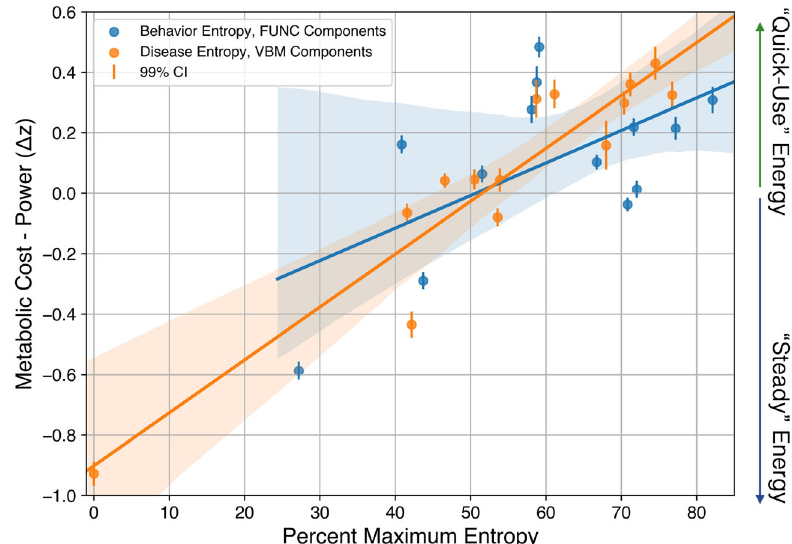
Fig. 5 Metabolic brain attributes vs. disease/behavior entropy. Using a published dataset capturing the dynamics of metabolic supply mismatching energetic demand (higher relative cost vs. power) among n = 28 healthy subjects, we performed linear regression with n = 14 percent maximum disease and n = 13 behavior network entropy metrics as separate independent variables (matched VBM and functional components, colored orange and blue, respectively). Both regressions were found to be signi fi cant after correcting for multiple tests, p = 7e − 7 and p = 0.03, for disease – structural and behavior – functional network data, respectively. Source data are provided in Supplementary Data